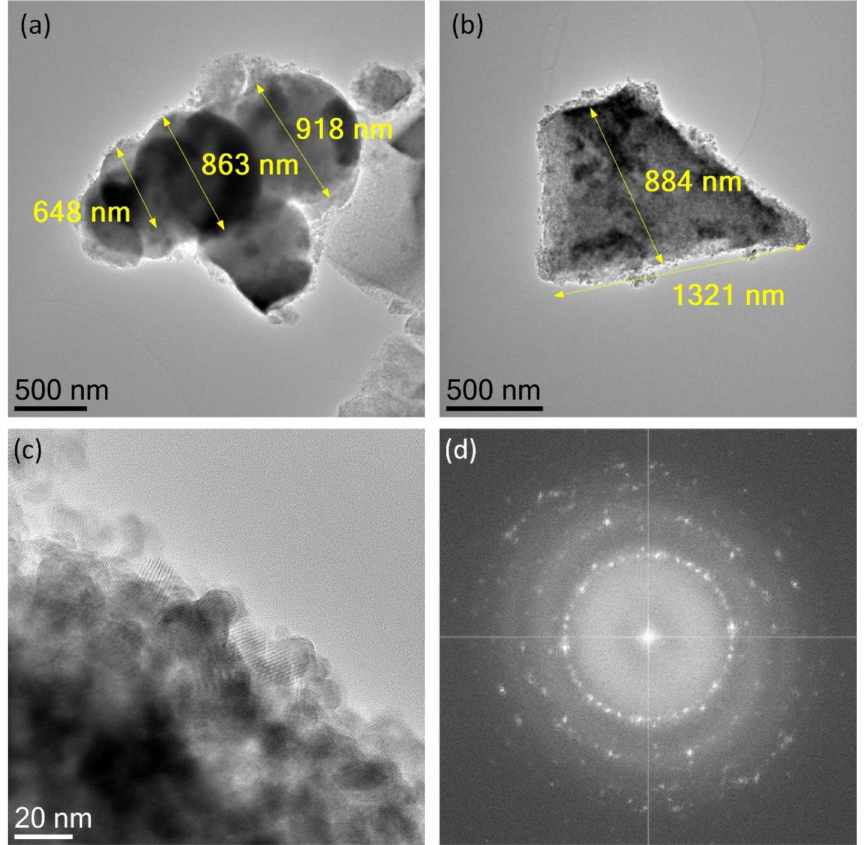
Figure 4. TEM images taken of ( a ) a conglomerate of submicron TiO 2 spheres and ( b ) an irregular TiO 2 grain crystallized by the 2:1 pH8 synthesis route. ( c ) HRTEM image recorded at the grain surface of ( b ). ( d ) Diffraction image digitally obtained from ( c ) after applying a fast Fourier transform.